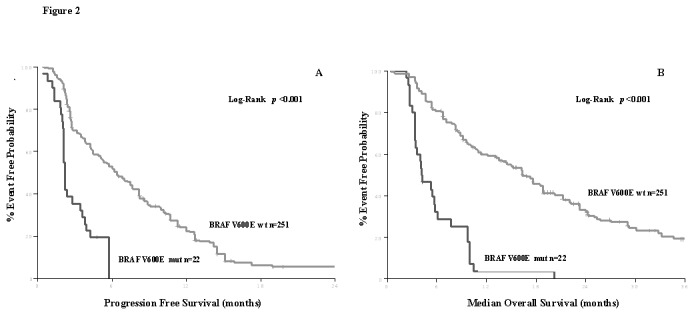
Progression Free Survival to salvage treatment with an anti-EGFR monoclonal (stratified for the treatment line) antibody according to BRAF
V600Emutation in 273 patients with metastatic Colorectal Cancer (A) and Median Overall Survival to salvage treatmentwith an anti-EGFR monoclonal antibody (stratified for the treatment line) according to BRAF
V600Emutation in 273 patients with metastatic Colorectal Cancer (B).